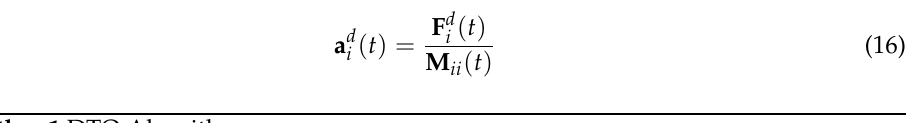
Algorithm 1 DTO